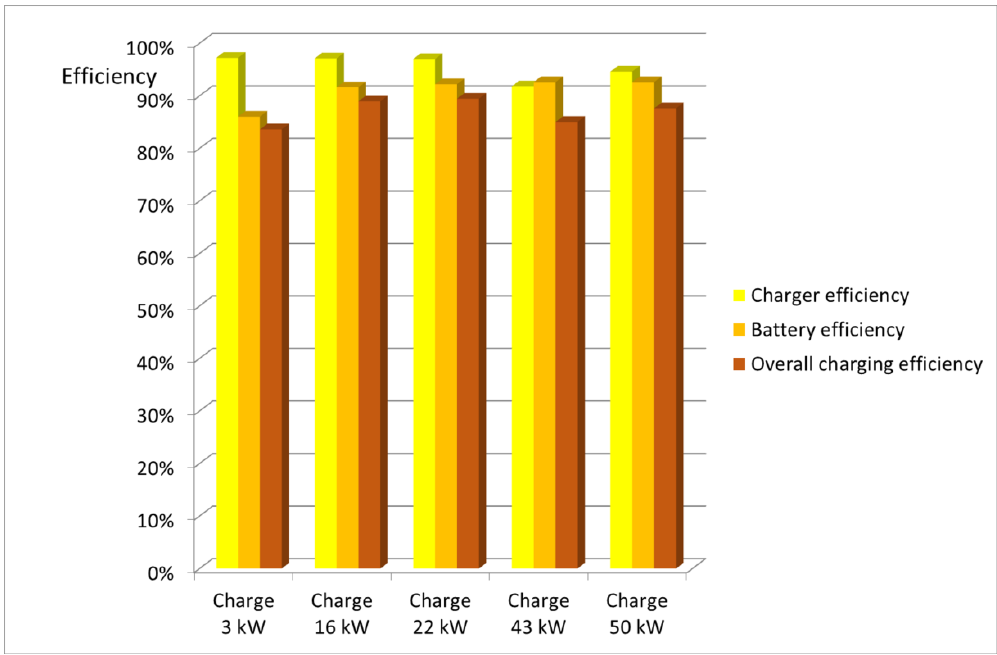
Figure 7. Charger efficiency, battery efficiency, and overall charging efficiency. Figure 7. Charger e ffi ciency, battery e ffi ciency, and overall charging e ffi